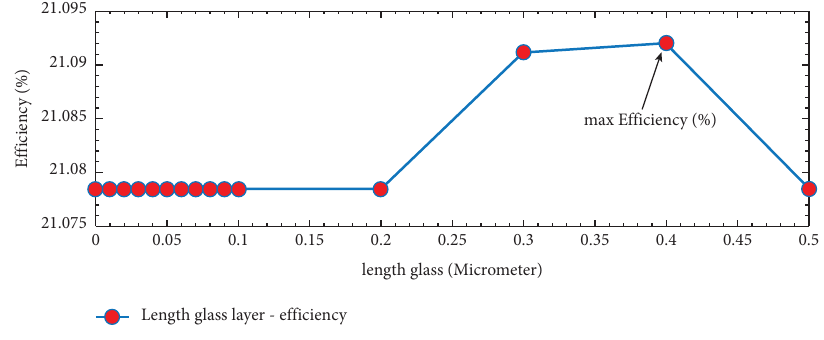
Figure 2: Efciency diagram in terms of TCO layer thickness.